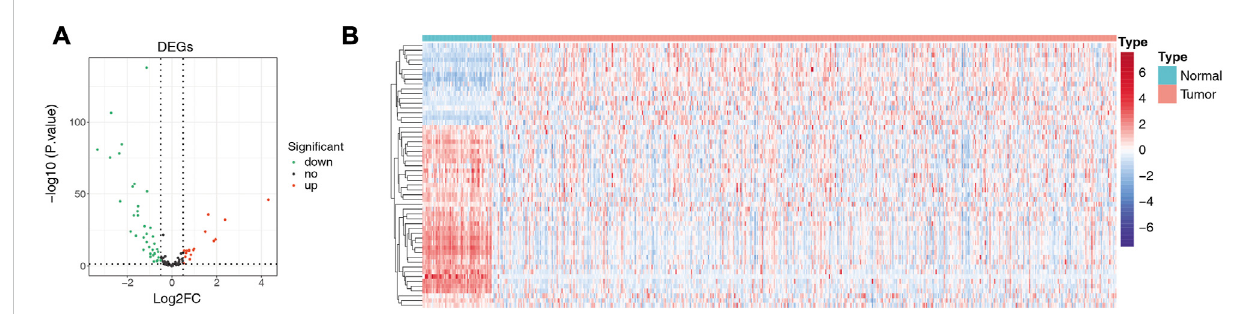
FIGURE 1 Detection of differentially expressed genes (DEGs). (A) Volcano plot showing DEGs between LUAD and adjacent normal tissues. (B) Heat map showing the expression pattern of all LUAD-related ARGs in normal and tumor groups; the X -axis indicates sample categories and Y -axis indicates DE- ARGs. Blue and red indicate down- and upregulation,